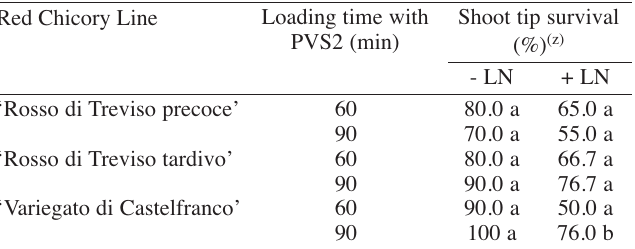
(z) For each select line and each column, percentages followed by dif- ferent letters are significantly different at P ≤ 0.05 by the χ 2